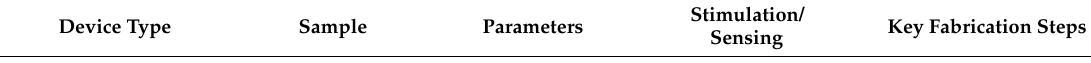
Table 1. An overview of the silicon-based resonator